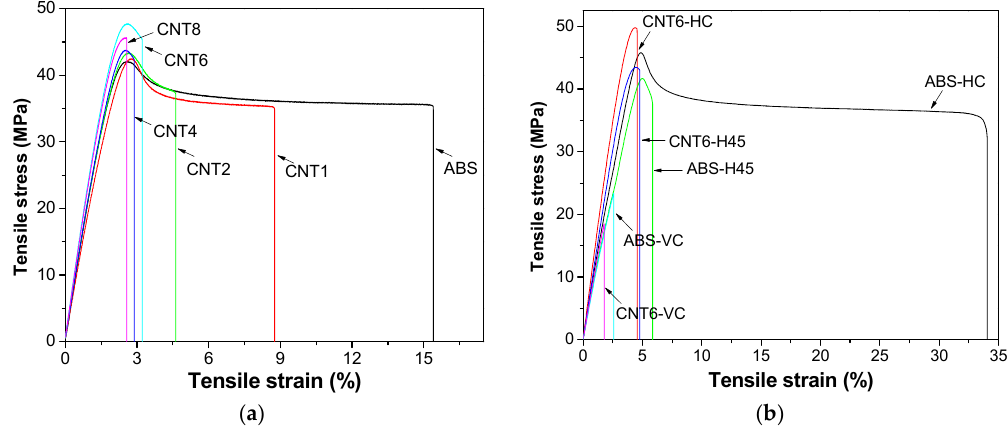
Figure 8. Tensile stress-strain curve of ABS and ABS-CNT filaments ( a ) and 3D-printed samples ( b ).